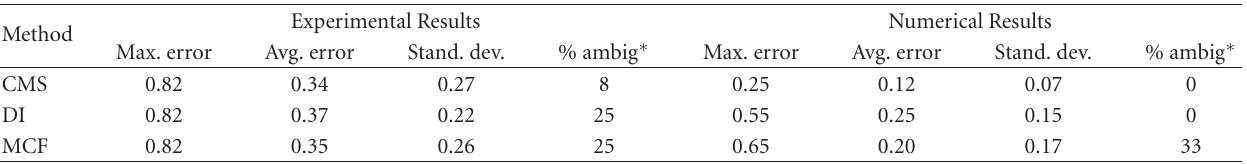
Figure 7: Correlation between predicted and actual longitudinal location of damage using six experimental measurement points and seven numerical measurement points, calculated by (a) CMS, (b) MCF, and (c) DI methods. Experimental data points are numbered according to the damage cases given in Figure 4. Table 2: Error in predicted damage location by each method, listed as a fraction of measurement point spacing. Experimental Results Numerical Method